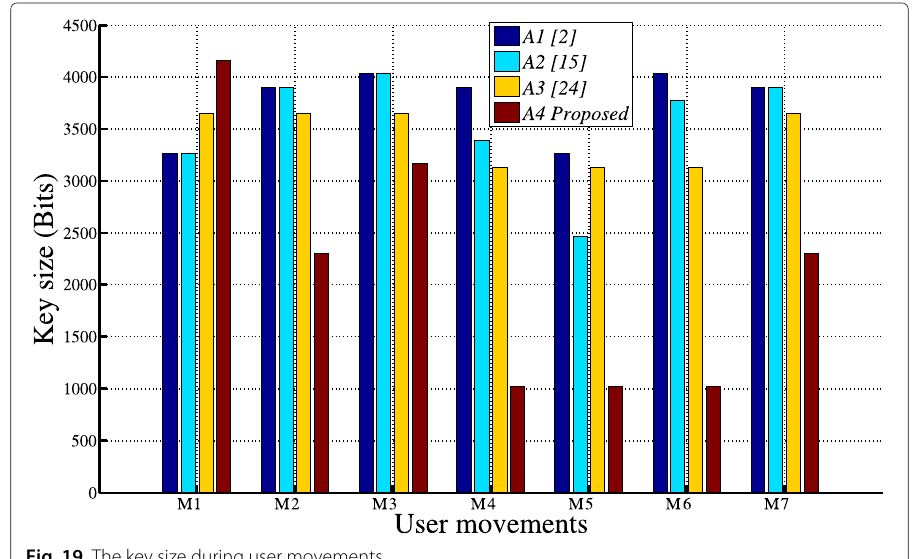
Fig. 19 The key size during user